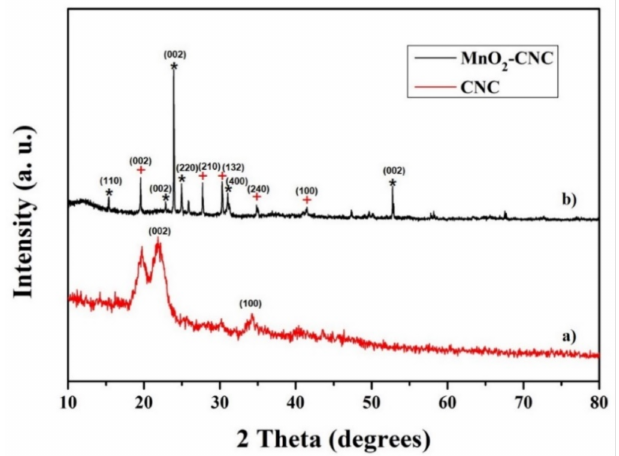
Figure 2. Powder XRD characteristic of ( a ) CNC and ( b ) MnO 2 -CNC nanocomposite.